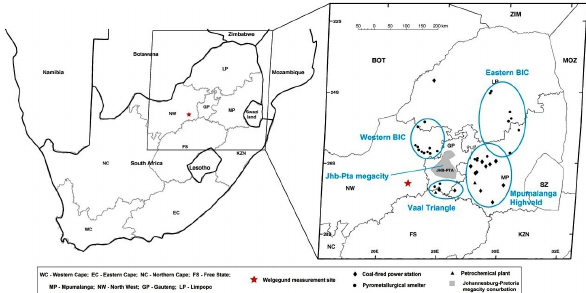
Figure 1. Map of southern Africa indicating the location of the Wel- gegund measurement station, large point sources in the industrial hub of South Africa and anthropogenic source regions impacting